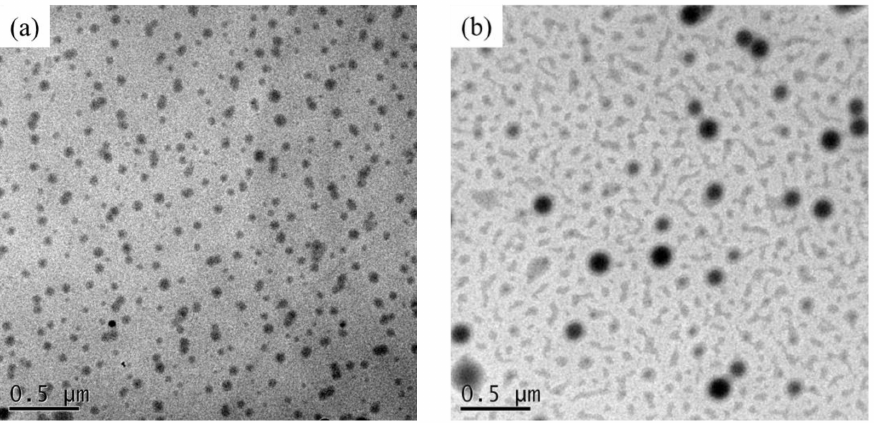
Figure 7. Transmission electronic microscopy (TEM) analysis of the as-prepared nanohybrid silica polyacrylate films. ( a ) Without adding DFMA and ( b ) DFMA/MMA weight ratio of 1:5.